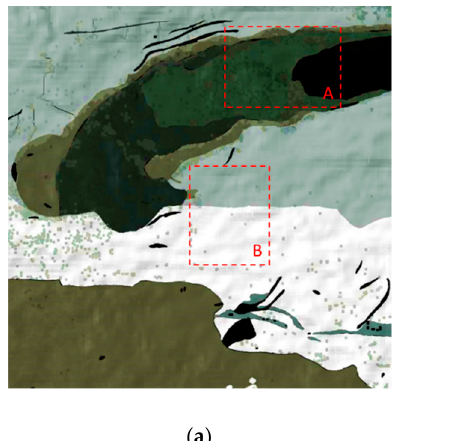
Figure 6. The BRF of samples collected with illumination zenith 45° and view zenith 0°.